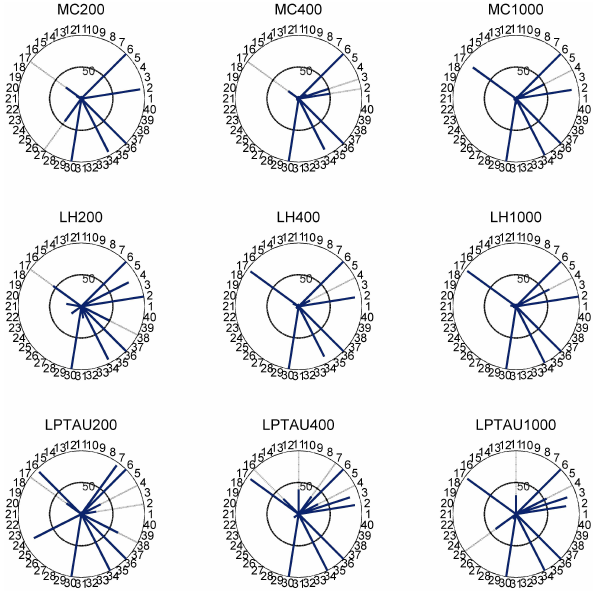
Fig. 4. The sensitivity score of sensible heat given by DT. The length of needles represents the sensitivity score.